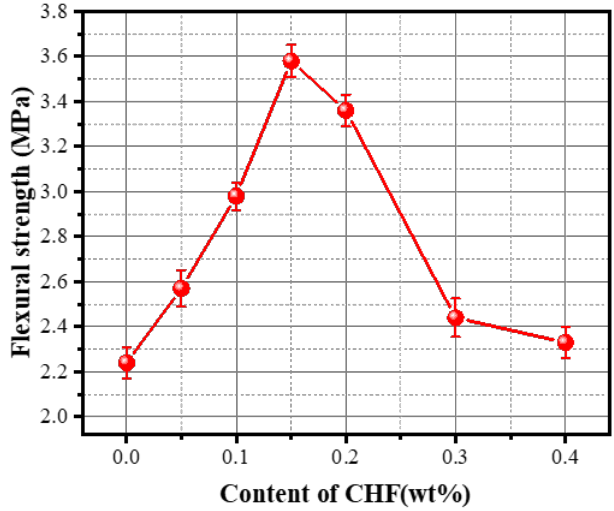
Figure 14. Influence of the content of CHF on the flexural strength of the material.